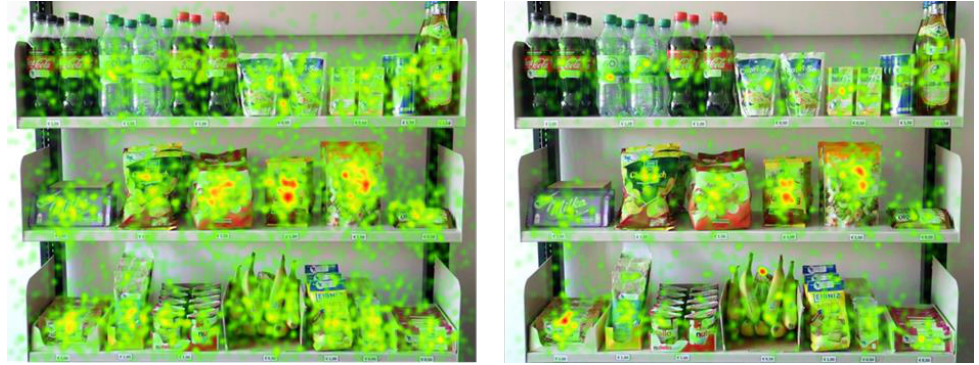
Figure 4. Heatmap of absolute fixation counts and absolute fixation duration.